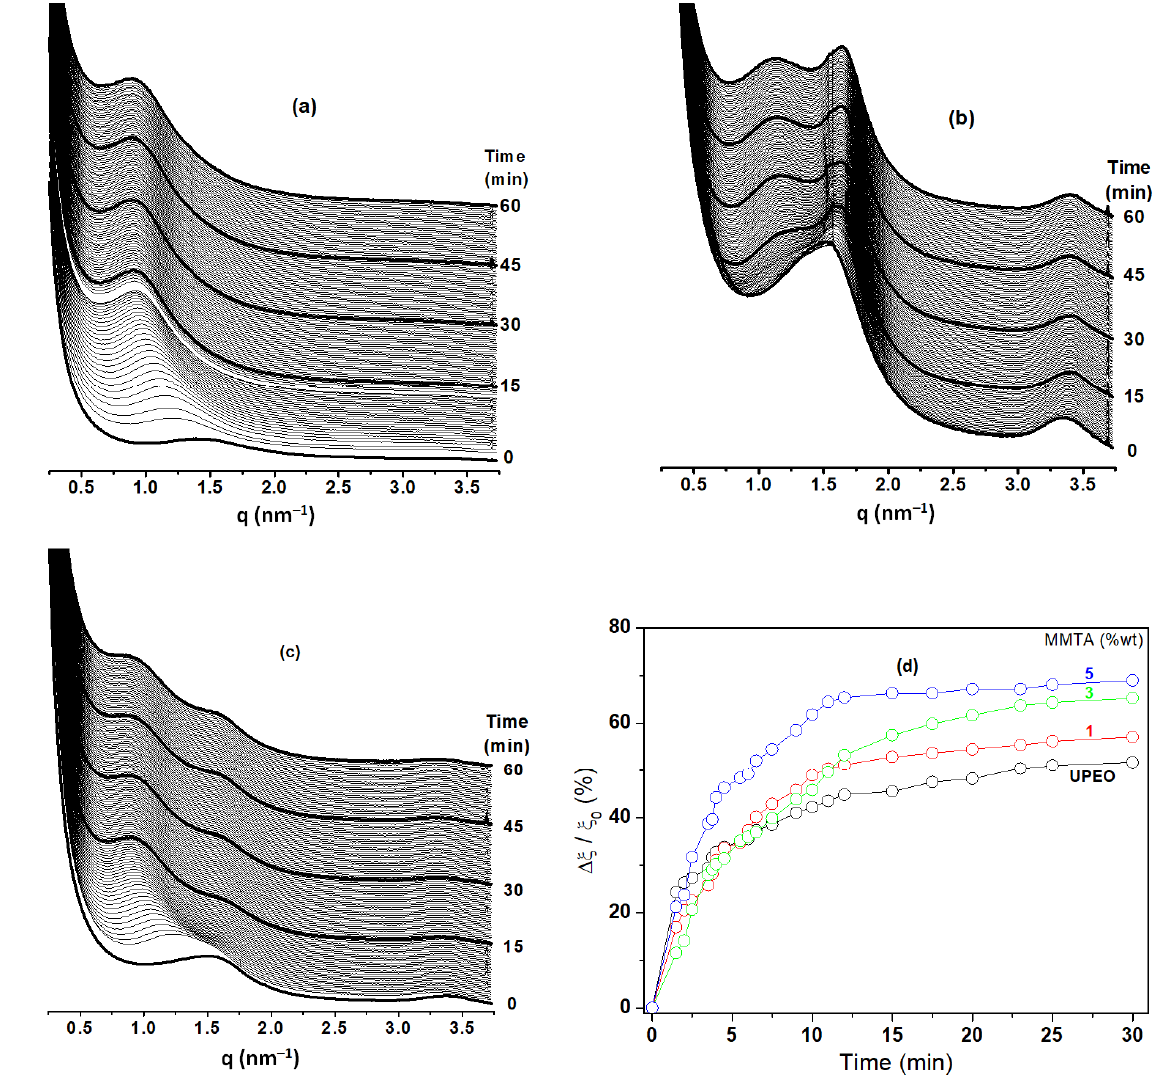
Figure 4. Time evolution of SAXS curves of ( a ) UPEO–MMTA1%, ( b ) UPEO-MMT3%, ( c ) UPEO-MMT5% nanocomposites recorded in situ during the swelling in water at 37 °C and ( d ) evolution of Δξ / ξ 0 as a function of the immersion time in water for hybrid UPEO and UPEO-MMT nanocomposites containing 1, 3, and 5% of MMTA.